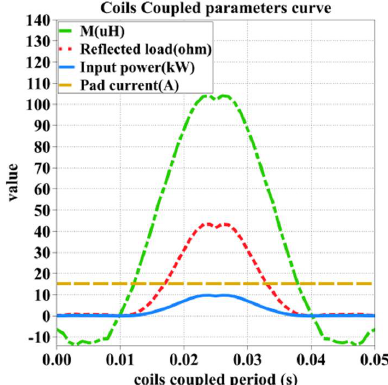
Figure 3. Parameters varied with M ( L p = 300 μH, L f 1 = 50 μH, Z s = 71.3 ohm, U in = 450 V, f = 85